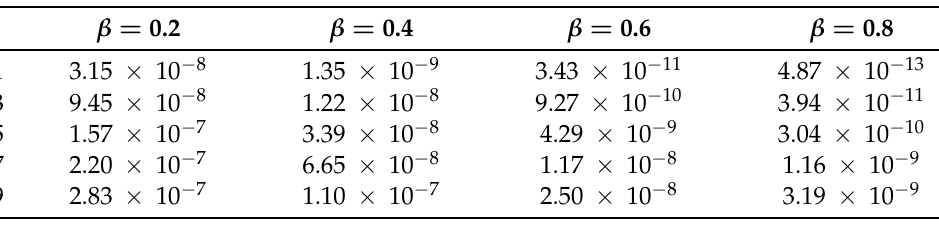
Table 2. Error analysis of LHPM in fractional domain for time-fractional Lax’s KdV model (Example 3) when k = 0.14 and x = 4.